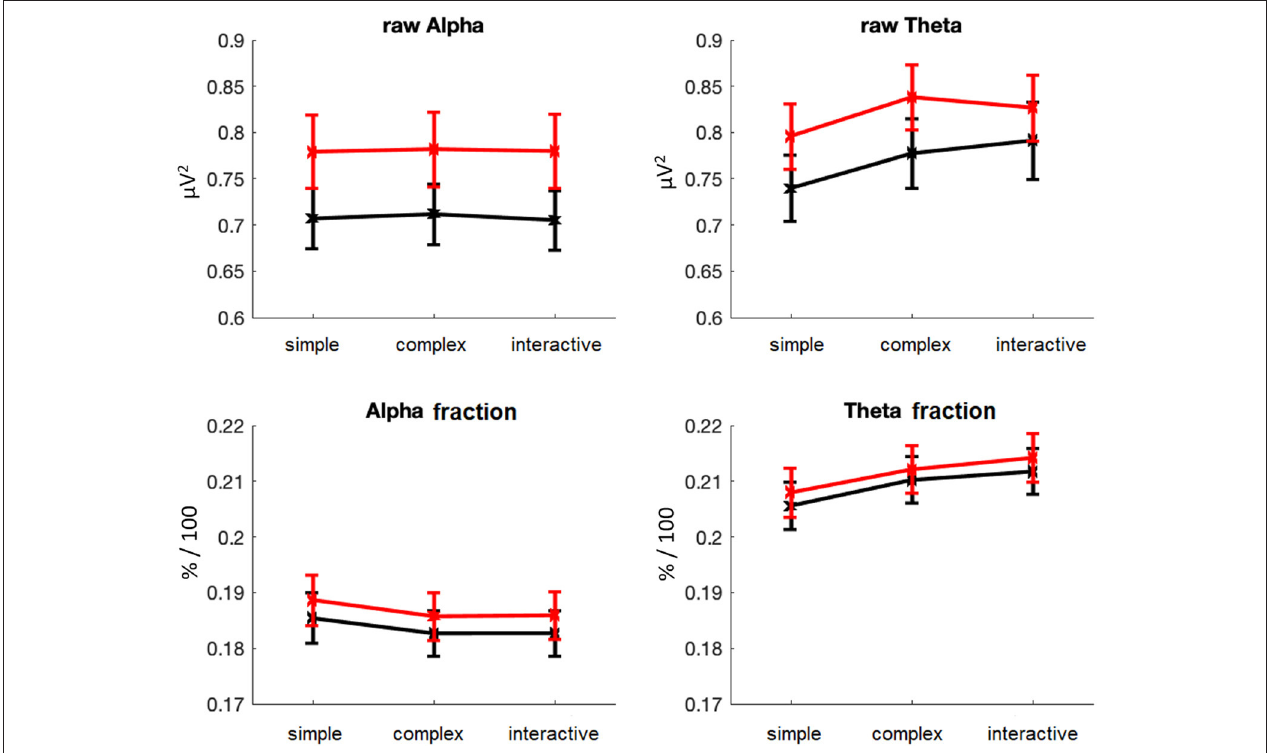
FIGURE 5 | Task-load related analysis of EEG parameters. Raw (upper row) and fractional (lower row) average power in the alpha (left) and theta (right) frequency bands as function of driving profile (simple, complex, interactive), shown separately for MP1 (black) and MP2 (red). Error bars indicate standard errors.